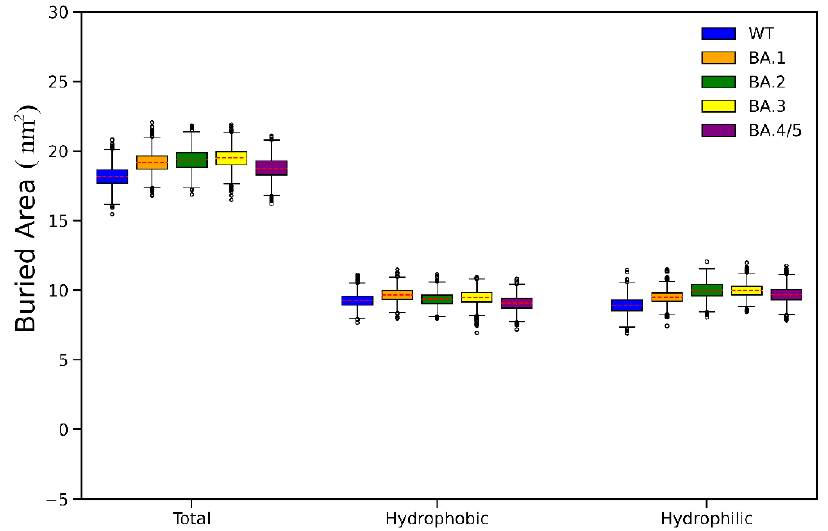
Figure 6. Boxplot of the buried total, hydrophobic and hydrophilic binding surface areas (BSAs) of the RBD-ACE2 binding interface. The average values are highlighted in red dotted line.